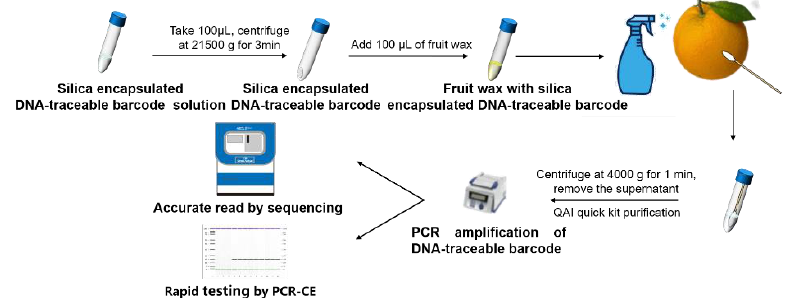
Figure 6. Recovery and detection of DNA-traceable barcode labels for Citrus sinensis.